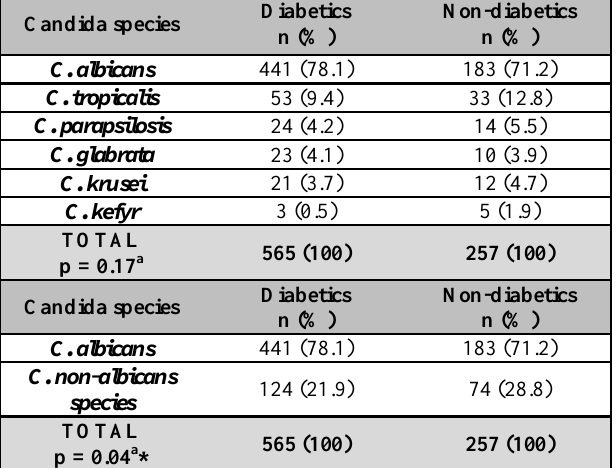
Table 3. Distribution of the different oral microbiota Candida species between diabetics and